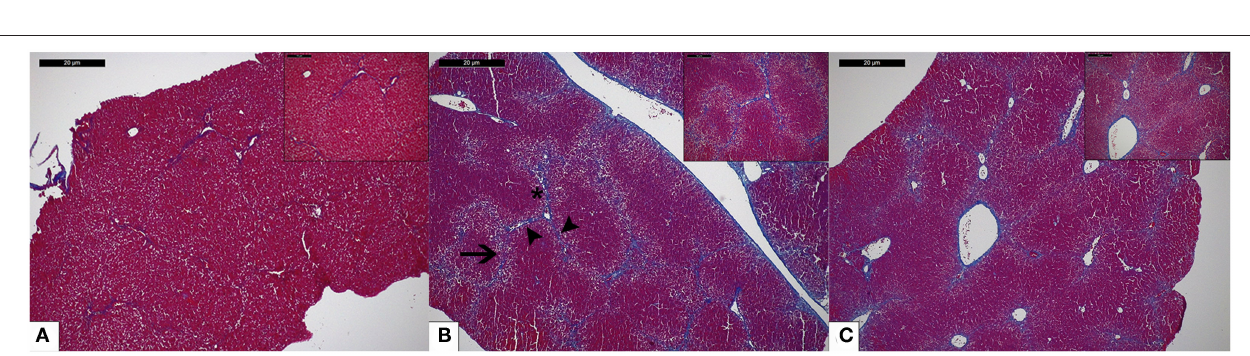
FIGURE 5 | Effect of OC on gene expression of NOX1 and NOX4 in LX-2 cells (A) and ROS production by HepG2 cells treated with H 2 O 2 (B) . * P < 0.05, ** P < 0.01, *** P < 0.001 vs. control, φ P < 0.05 vs. TGF- β 1-treated cells (A) or vs . H 2 O 2 -treated cells (B). Results are the mean of 3 independent experiments performed in triplicate and have been analyzed by one-way ANOVA followed by the Tukey’s post hoc test.